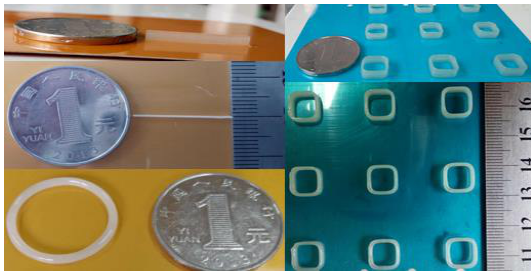
Figure 19. Printed simple model.